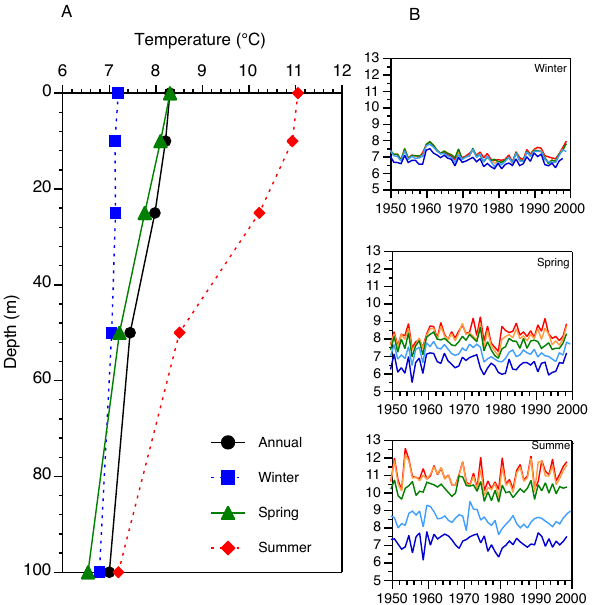
Fig. 7. (A) Seasonal and annual temperature averages for the last 50 years from Ocean Weather Station Mike in the upper 100m of the water column. Averages are based on the temperature records presented in (B) . From Nyland et al.